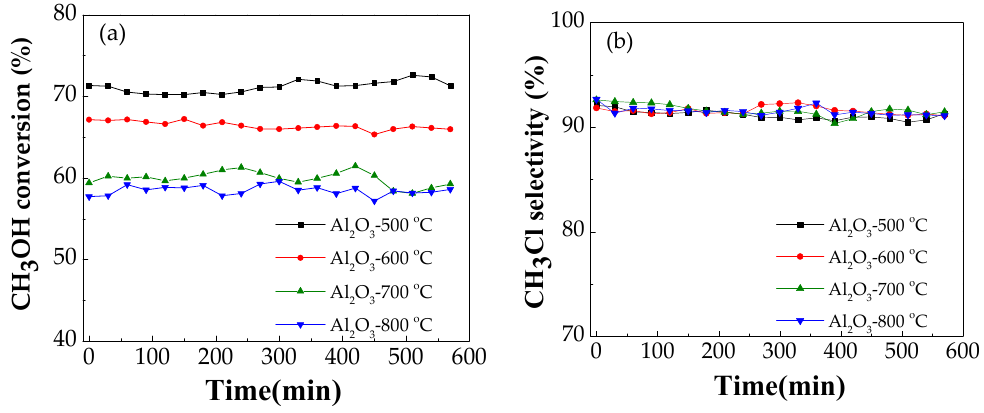
Figure 3. The methanol conversion ( a ) and the methyl chloride selectivity ( b ) over mesoporous alumina with different calcination temperatures (Conditions: 4.75 g MeOH ∙ g − 1 (cat.) ∙ h − 1 , temperature 280 °C).